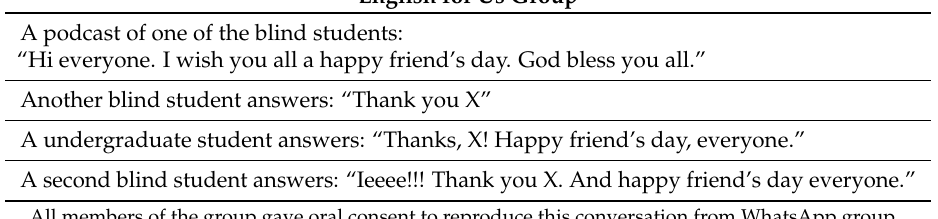
Table 2. Transcript 2: Happy Friends Day